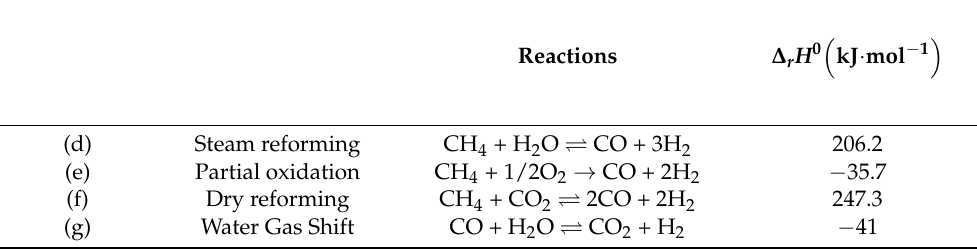
Table 3. Chemical reactions involved in production of syngas (enthalpy of reaction at 298